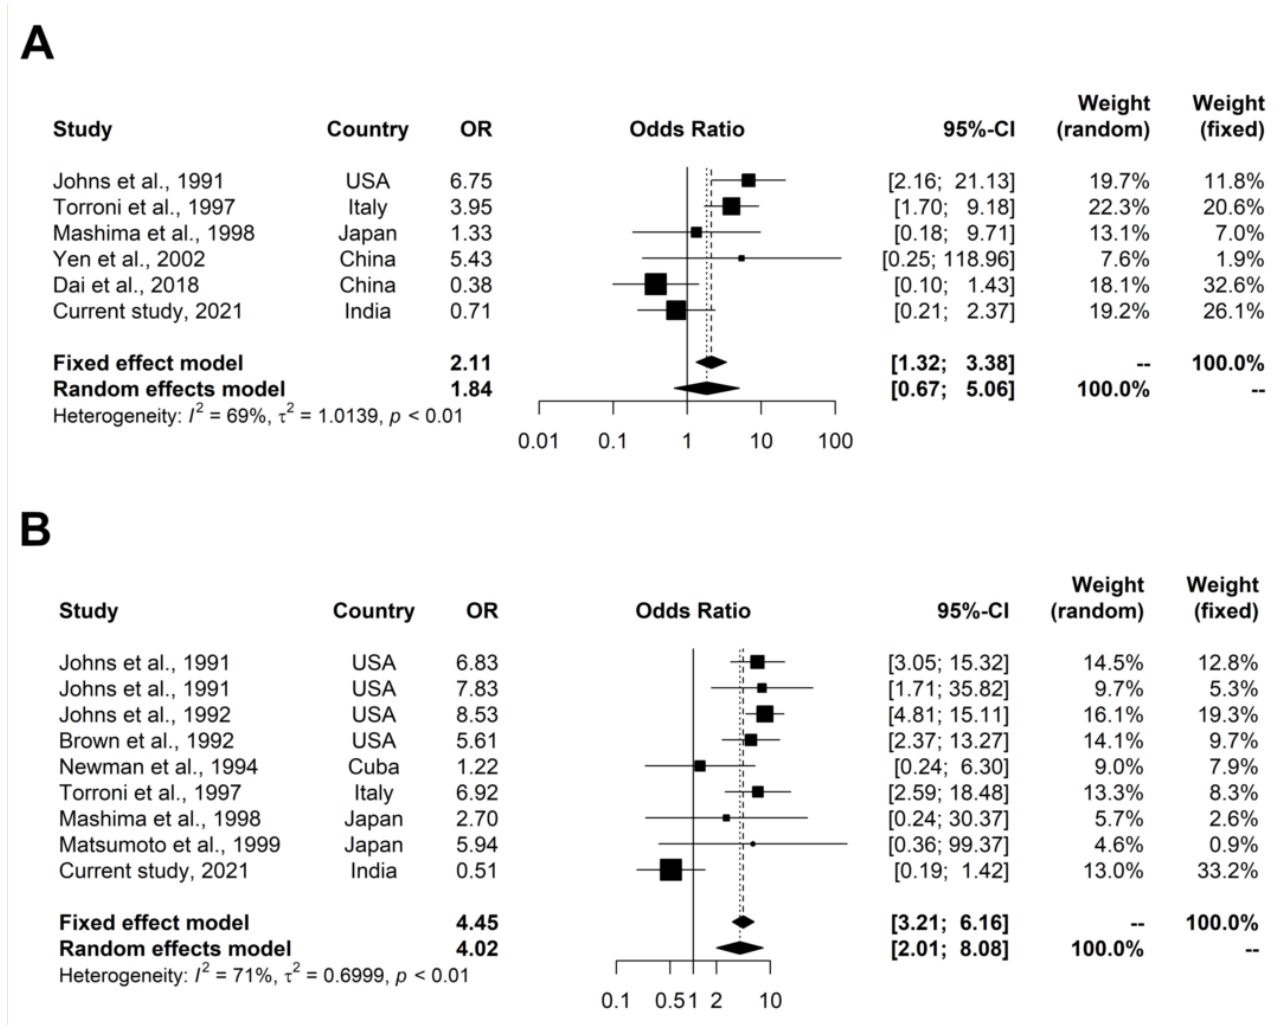
Figure 2. Forest plot showing odds ratios (ORs) for individual studies and pooled odds ratio (OR) using both fixed- and random-effect models of meta-analysis for ( A ) m.4216T>C variant and ( B ) m.13708G>A variant. The publication bias was assessed using a funnel plot and Egger’s test. The funnel plot (Figure 3) indicated no publication bias, which was quantitatively confirmed by Eg- ger’s test ( p 4216 = 0.6545; p 13708 = 0.3448).